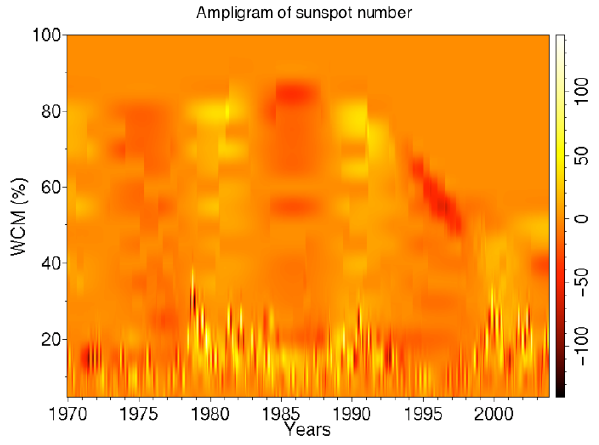
Fig. 4. The ampligram of the sunspot number from 1970 to 2004. WCM ( % ) stands for the fraction of the maximum of the wavelet coefficient magnitude. Fig. 5. Time scale spectra of sunspot number for the period 1850 to 2002 (upper panel) and 1975 to 2002 (lower panel).